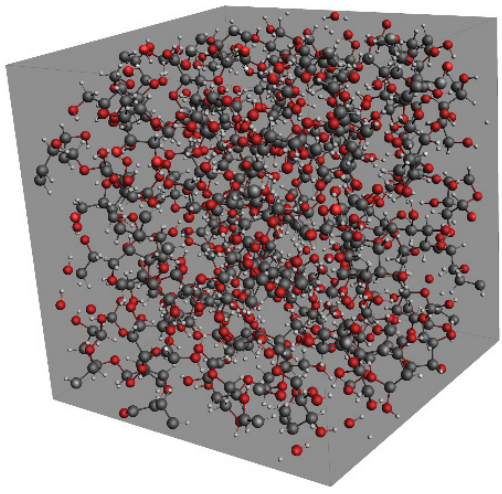
Figure 5. Molecular model of 40 cellobioses.